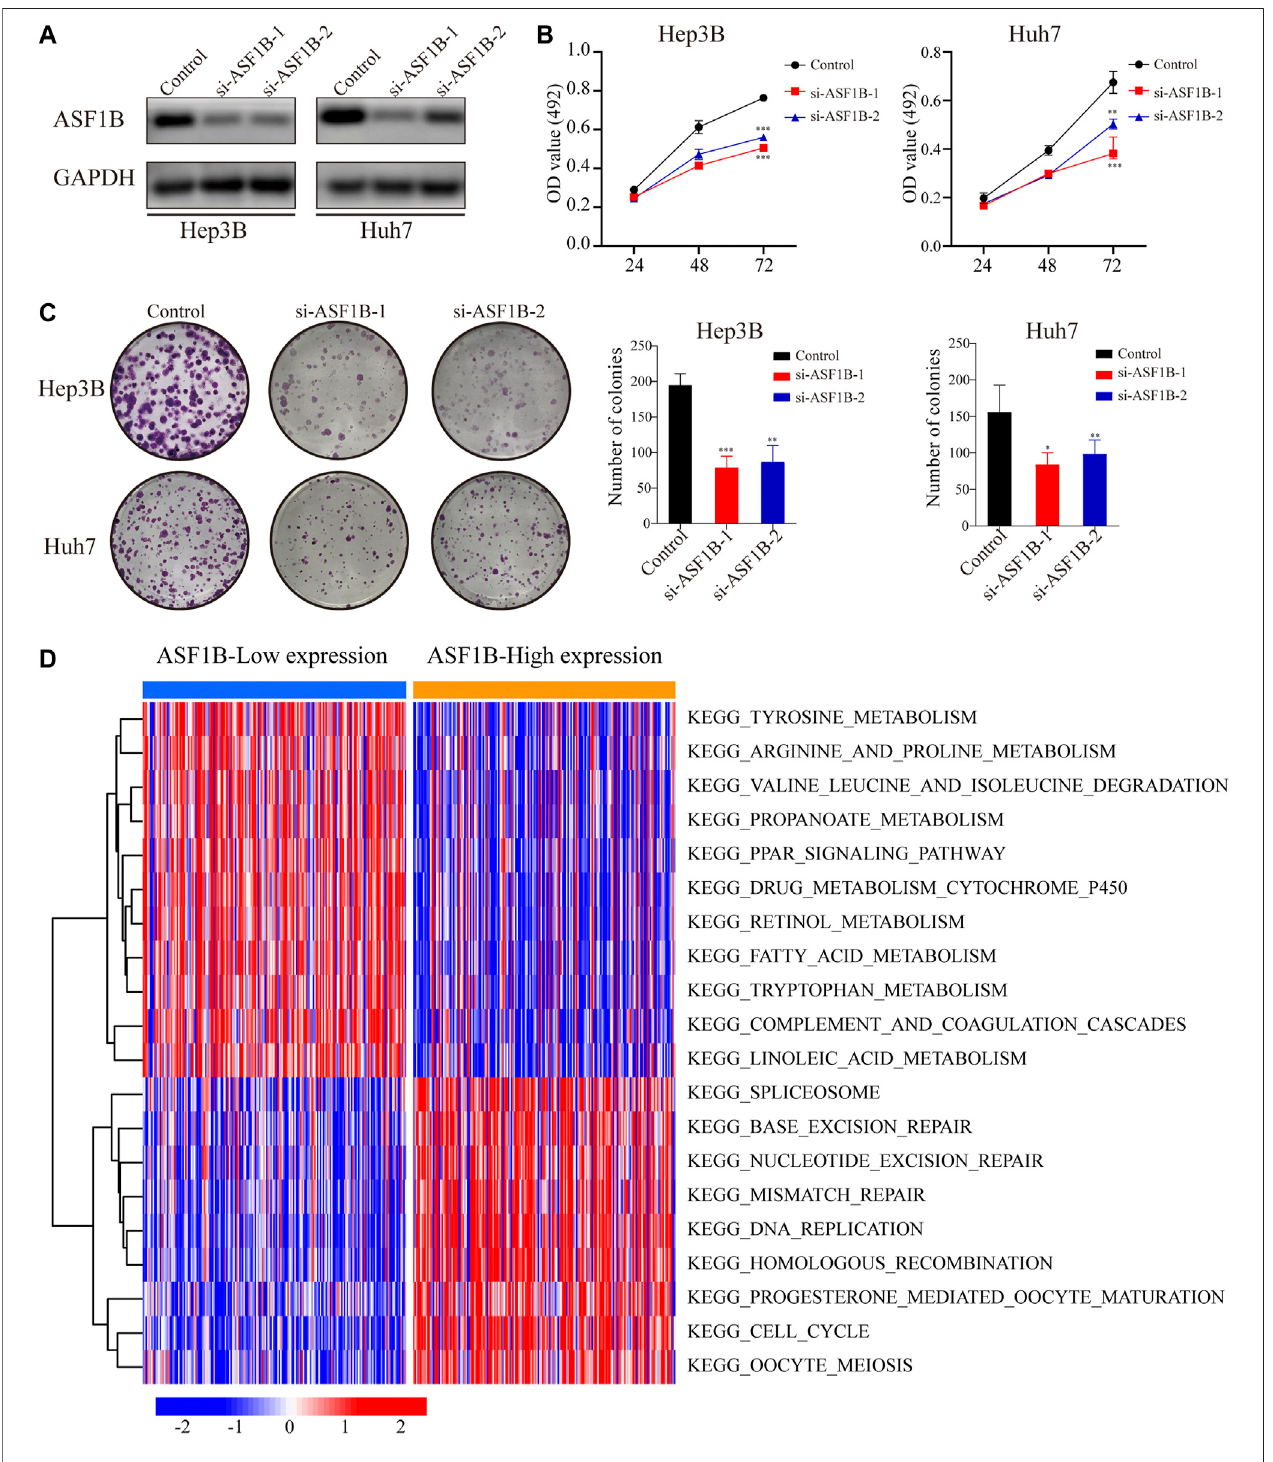
FIGURE5| DownregulationofASF1BinhibitstheproliferationofHCCcells. (A) TheproteinlevelsofASF1BweredetectedusingWesternblottingaftertransfection of two independent sets of ASF1B-targeted siRNAs in Hep3B and Huh7; The proliferation of HCC cells was detected by (B) MTT assay and (C) the colony formation assay; (D) Functional enrichment analysis of ASF1B-correlated genes in HCC through GSVA. The red node represents up-regulation and the blue node represents down-regulation. * p < 0.05; ** p < 0.01; *** p < 0.001.